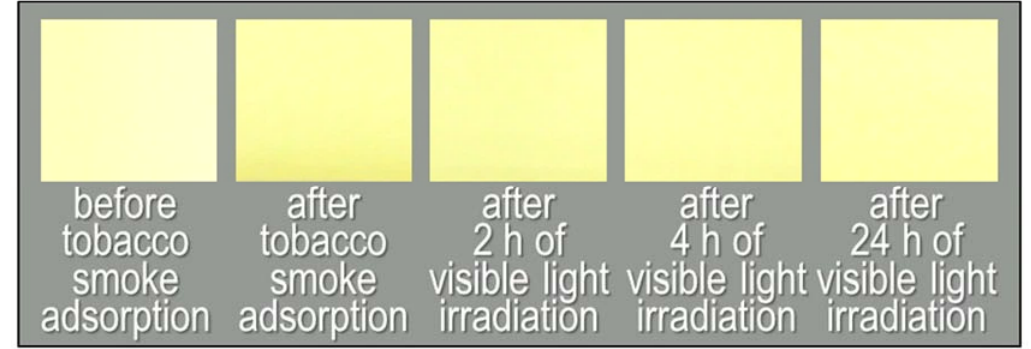
Figure 9. Photographs of the non-woven fabric with Cu / WO 3 before tobacco smoke adsorption, after tobacco smoke adsorption (0 h), and after 2, 4, and 24 h of visible light irradiation.